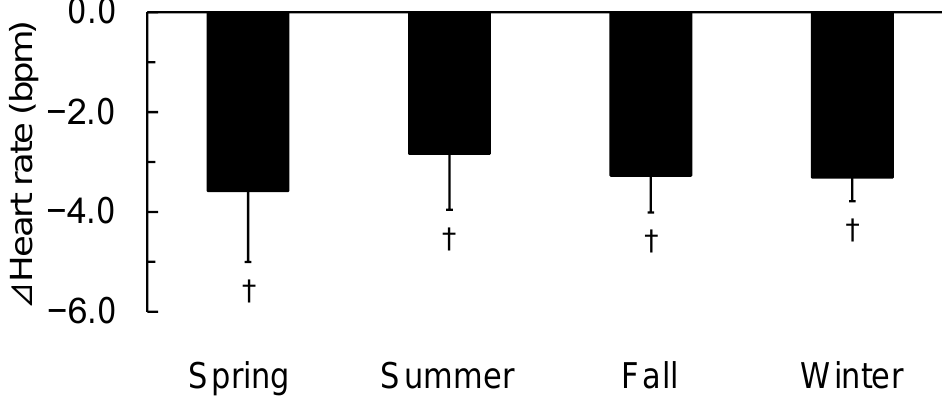
Figure 5. Differences in the changes in heart rate between walking in an urban park and walking in a city area according to the four seasons. n = 51 (spring: n = 12, summer: n = 12, fall: n = 20, and winter: n = 7); mean ± standard deviation, †: p < 0.05 using the paired t -test (urban park vs. city area).